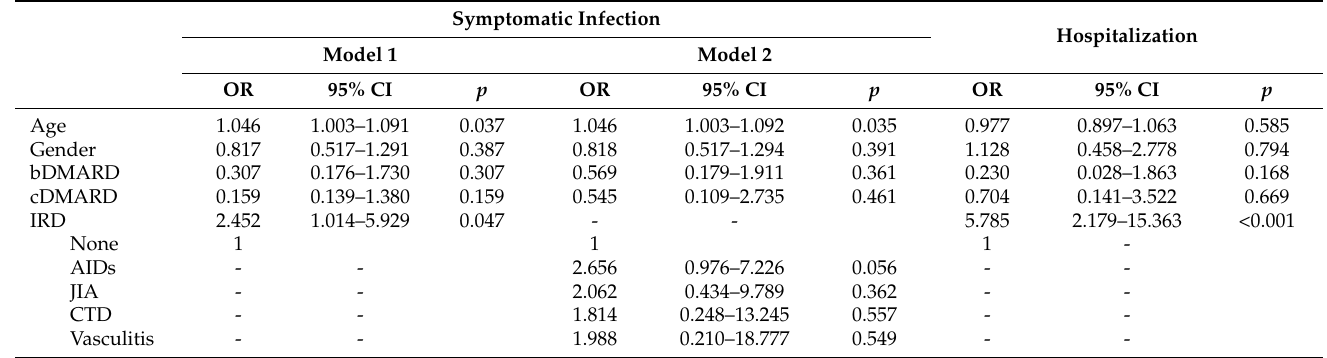
Table 3. Risk factor assessments for symptomatic infection and hospitalization due to COVID-19. Symptomatic